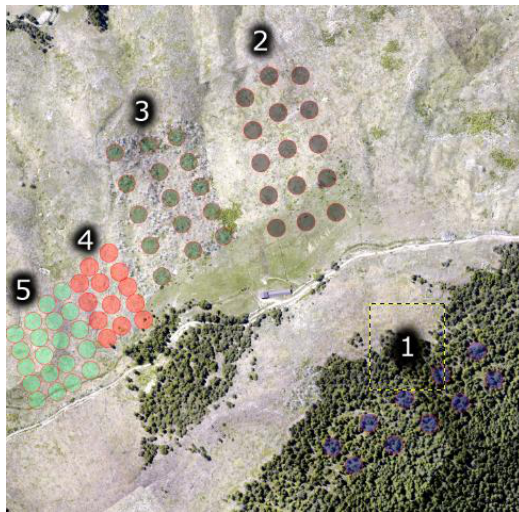
Figure 1. ROI with the five sectors with circular sample plots